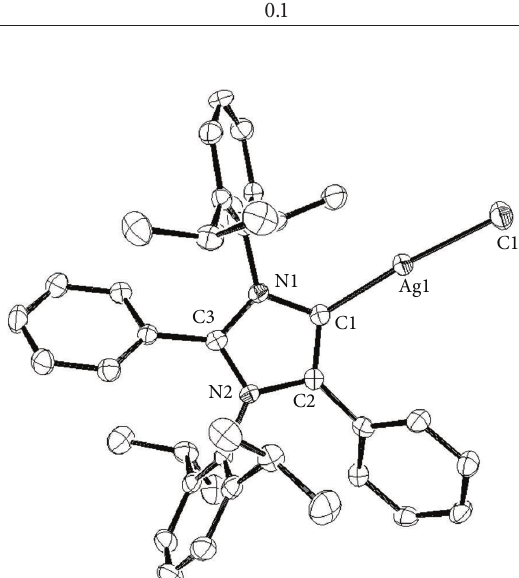
Figure 1: ORTEP representations for silver carbene complex 14